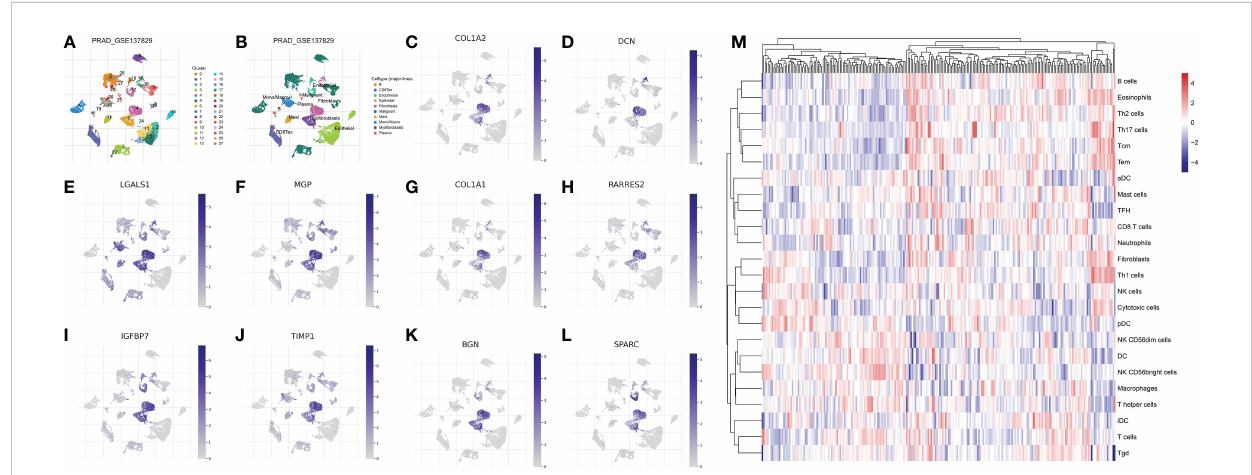
FIGURE 1 (A, B) The single-cell RNA plot of the GSE137829 dataset; The single-cell RNA sequencing analysis of COL1A2 (C) ; DCN (D) ; LGALS1 (E) ; MGP (F) ; COL1A1 (G) ; RARRES2 (H) ; IGFBP7 (I) ; TIMP7 (J) ; BGN (K) ; SPARC (L) ; (M) The results of the ssGSEA